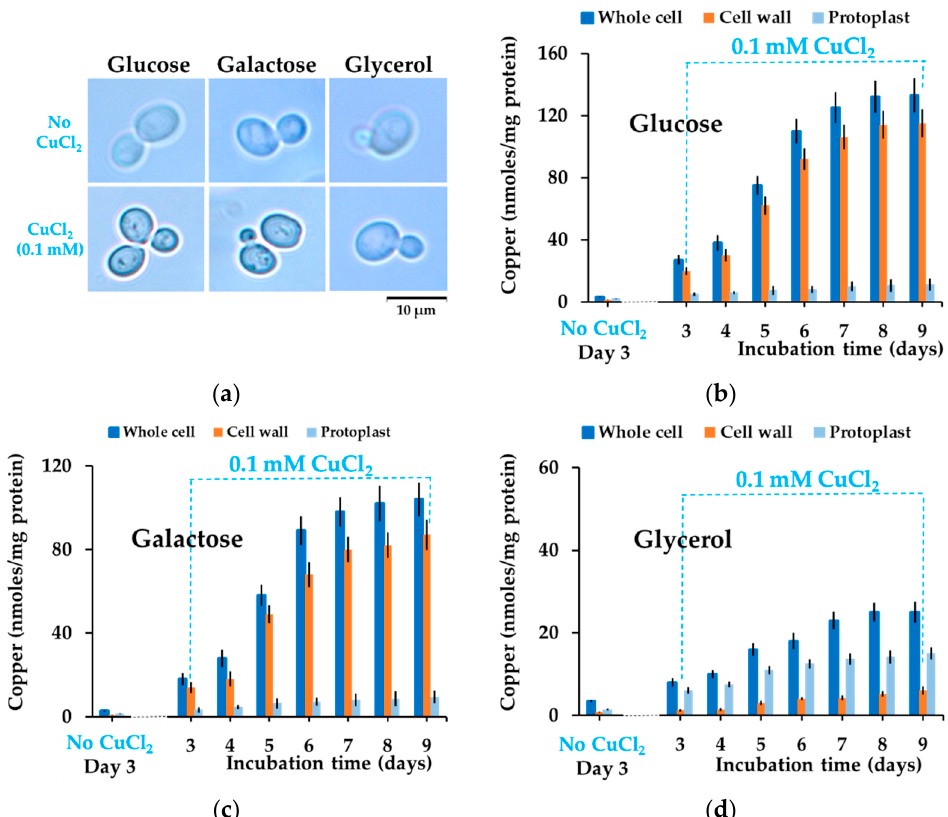
Figure 2. Accumulation of copper by Saccharomyces cerevisiae cells exposed to CuCl 2 on solid media. Exponentially growing cells of wild-type strain BY4741 were spotted (5 µ L of 1 × 10 6 cells/mL suspensions) on agar plates containing MM/Glc (Glucose), MM/Gal (Galactose), or MM/Gly (Glycerol) with or without 0.1 mM CuCl 2 . ( a ) Visualization of copper bound to yeast cell surface. Cells grown on agar plates for 6 days were suspended in 5 µ L of buffer containing 0.1 mM bathocuproine disulfonate (BCS) directly on microscope slide. Cells were visualized in bright field 10 minutes after BCS staining. ( b – d ) Copper accumulation by cells grown statically on solid agar media and its distribution between cell wall and protoplasts. Cell suspensions were spotted on agar plates as in ( a ) and incubated in a dark incubator. Starting from day 3, cell patches were harvested and processed for copper assay, as described in Section 2. Cells from the same batch in MM/Glc ( b ), MM/Gal ( c ), or MM/Gly ( d ), were used to determine whole-cell copper, cell wall copper, or copper accumulated in protoplasts. Values were normalized to cell total proteins in the corresponding intact cells. Values are mean ± SEM of triplicate determinations done on three biological repeats.